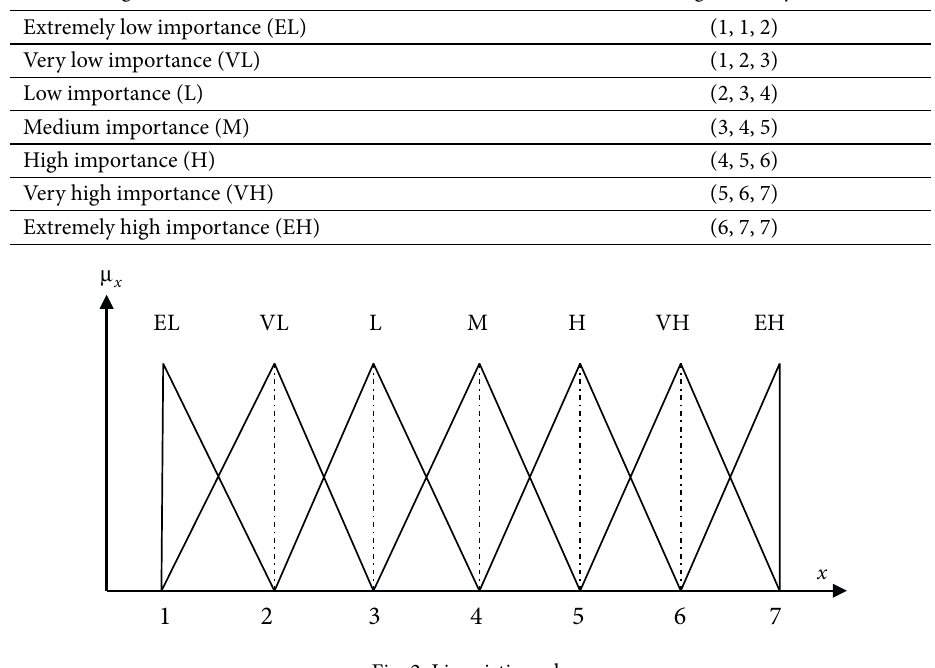
Table 1. Triangular fuzzy conversion scale for the alternatives Linguistic scale for criteria and alternatives Triangular fuzzy scale